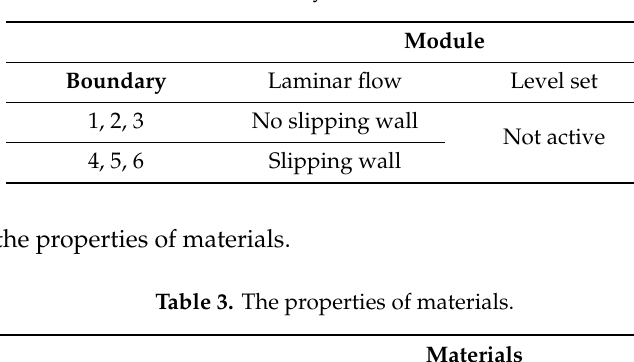
Table 2. The boundary conditions of the model.